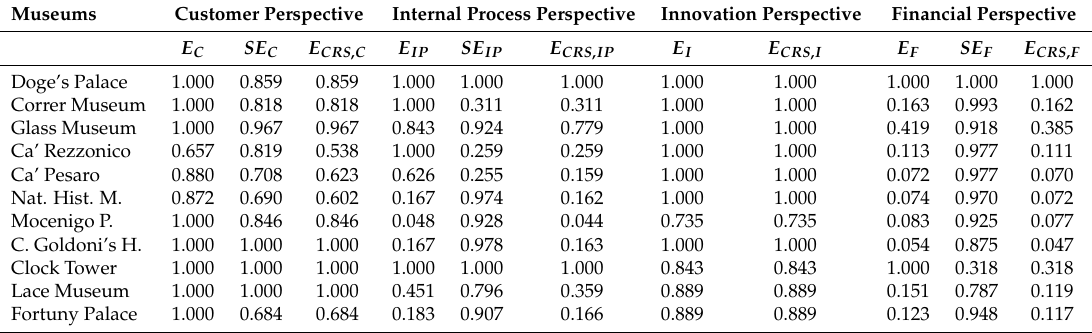
Table 7. Decomposition of the global technical efficiency scores of the first stage DEA models into pure technical and scale